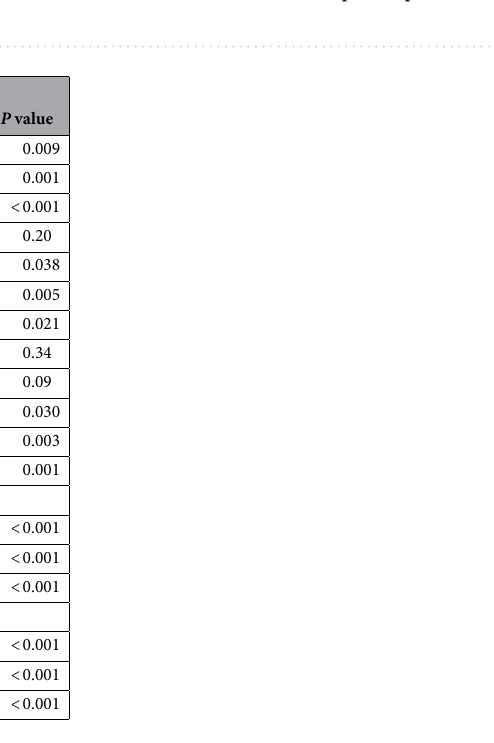
Table 3. Simplified risk prediction model for persistent AKI. AKI, acute kidney injury; CI, confidence interval; PaO 2 , partial pressure of oxygen; PaCO 2 , partial pressure of carbon dioxide; INR, international normalized ratio; PTT, partial thromboplastin time; RRT, renal replacement therapy; SCr, serum creatinine; UO, urine